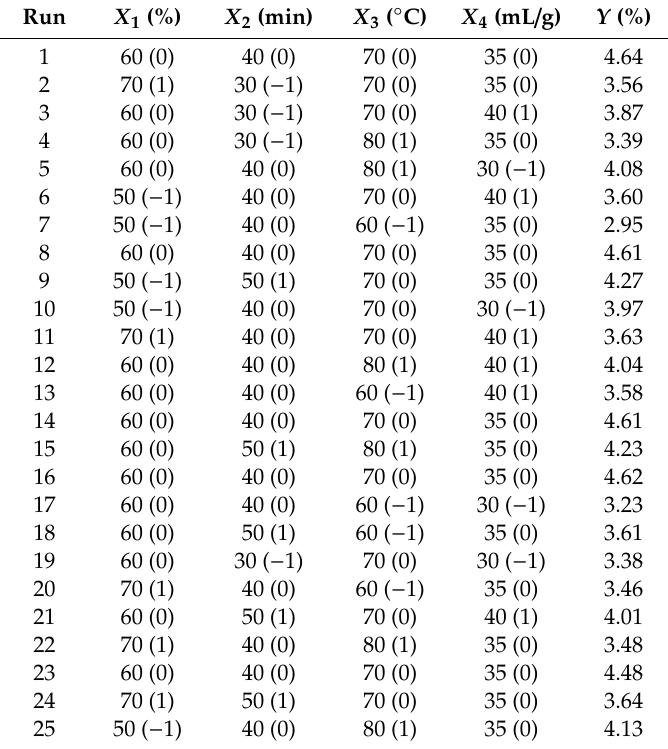
Table 1. Box–Behnken design matrix and experimental values for the